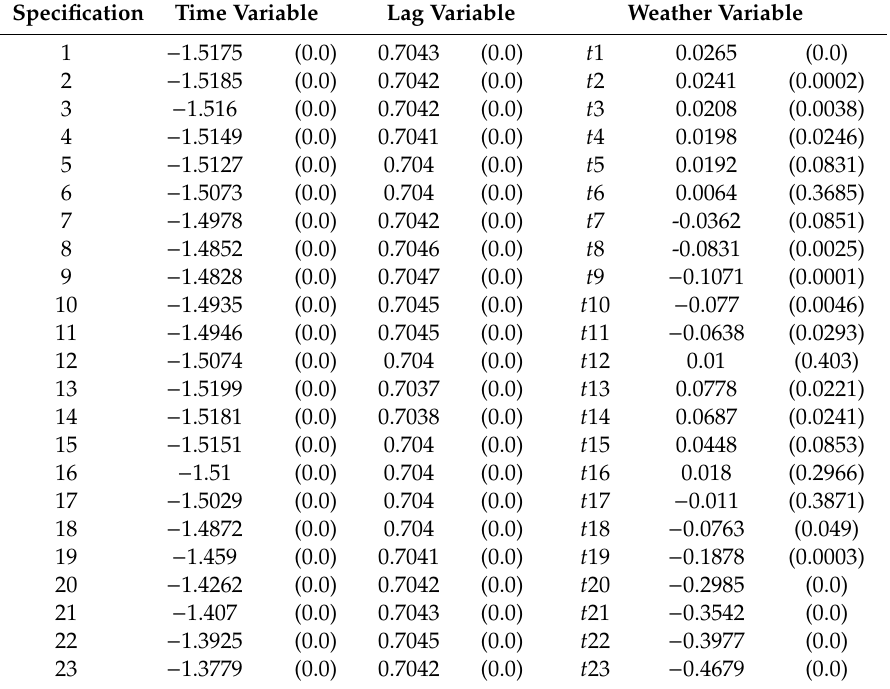
Table 1. Estimation results for time, lag performance, and